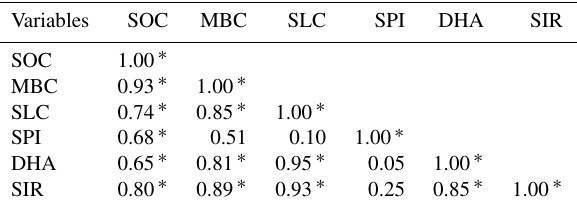
Table 4. Correlation coefficient (Pearson, n − 1) of the observed variables from long-term nutrient management